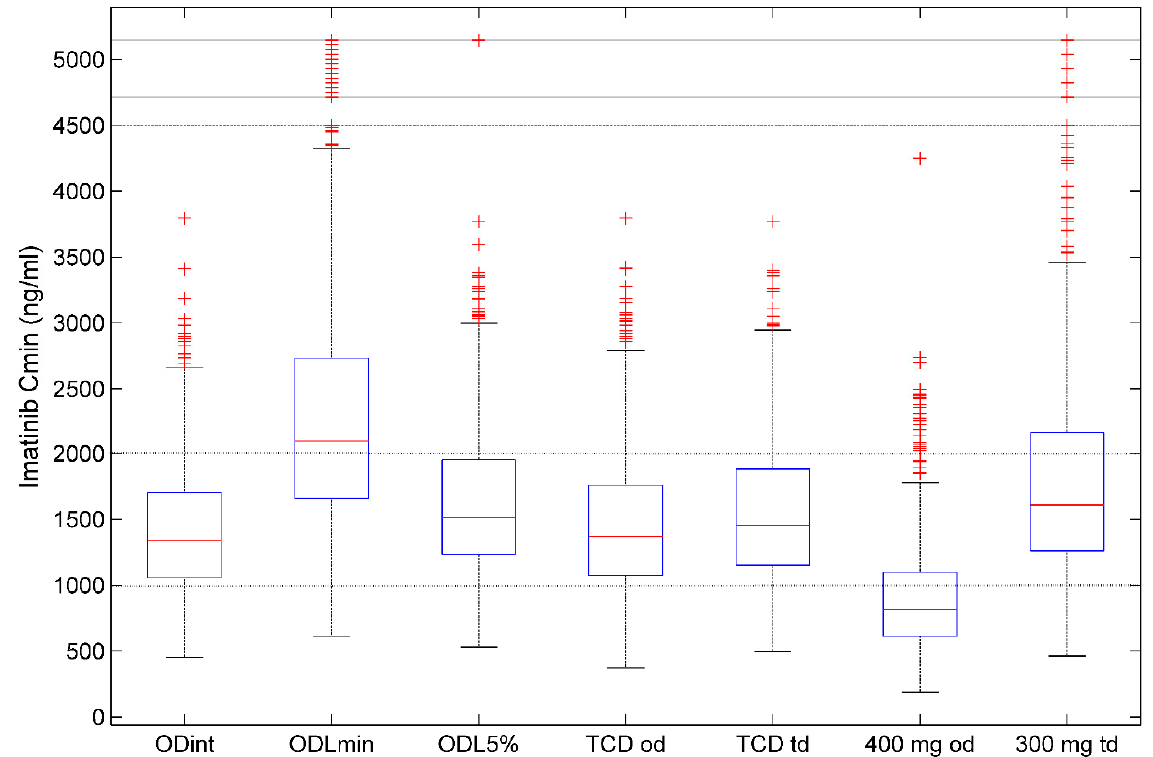
Figure 4. Boxplot of imatinib trough concentrations achieved in simulated patients with various dosing methods targeting the interval 1000–2000 ng/mL. The box edges represent the 25th and 75th percentiles of Cmin distributions. The central mark is the median. The length of whiskers is equal to 1.5 times the interquartile range. The plus signs are outlier values. For ease of graphical display, Cmin values greater than 4500 ng/mL are all compressed in the upper area between the two grey solid lines. Of note, the proportions of Cmin values within and outside the target interval are slightly different from those shown in Table 1 because the data represented graphically are restricted to the 791 Cmin values that could be computed with all methods. Abbreviations: Cmin, trough concentration; od, once daily administration (every 24 h); td, twice daily administration (every 12 h); TCD, target concentration dosing.